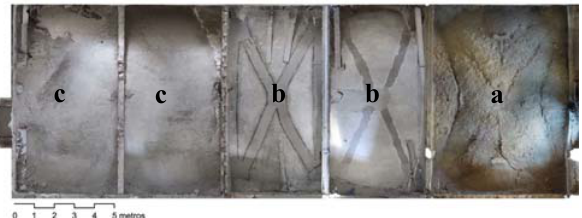
Figure 10: comparing cloud to cloud with Cloudcompare.